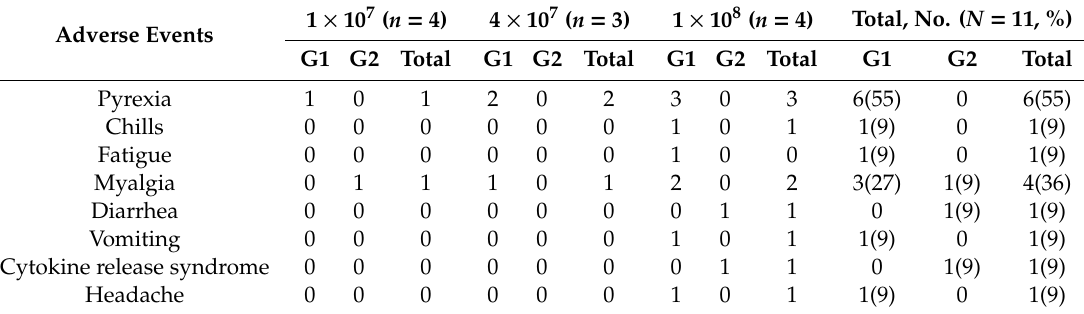
Table 2. Treatment-related adverse events of any grade observed in the study ( n =